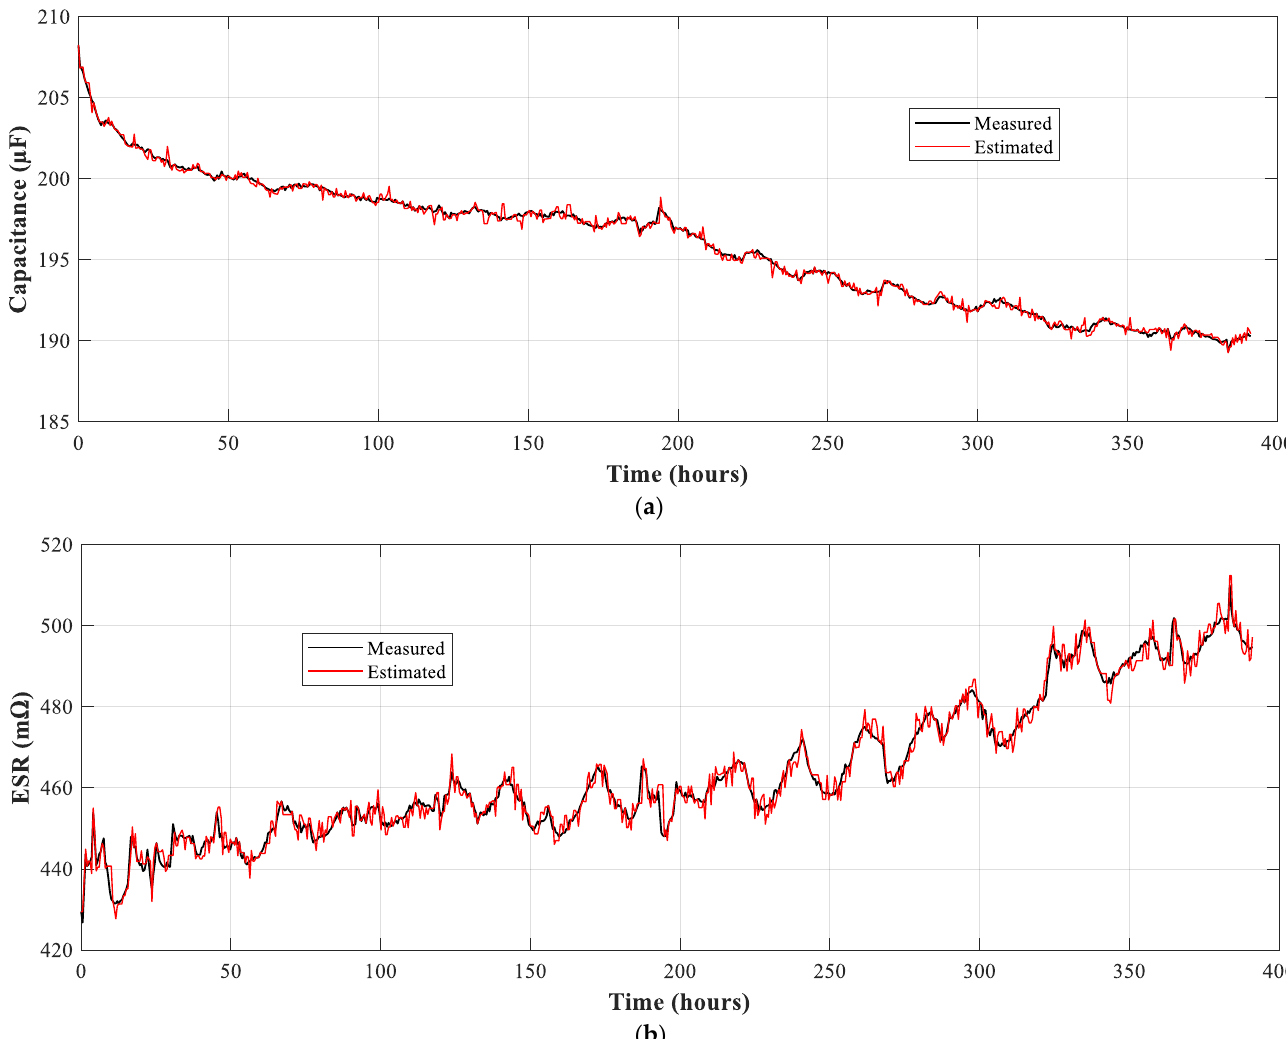
Figure 10. Experimental setup to acquire data from DC-DC converter.